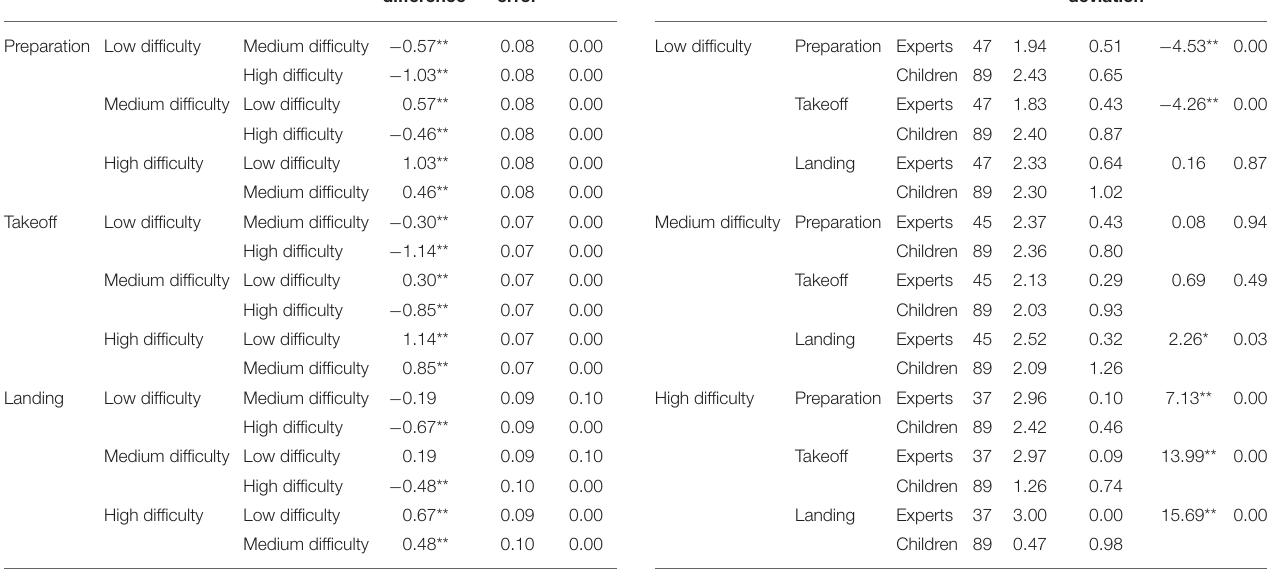
Preparation Low difficulty